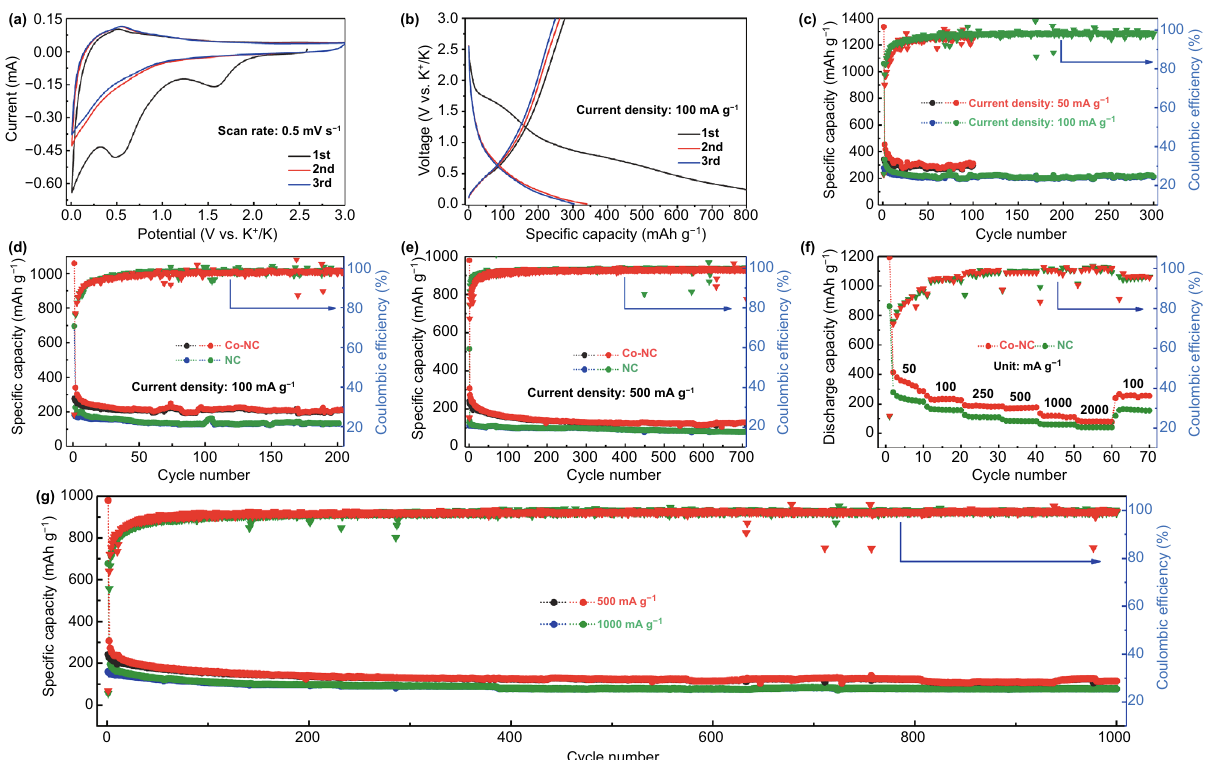
Fig. 2 a CV curve of Co-NC anode at 0.5 mV s −1 , b GCD curve of Co-NC anode at 100 mA g −1 , c cycling performance and corresponding CE of Co-NC anode at 50 and 100 mA g −1 , d cycling performance and corresponding CE of Co-NC and NC anodes at 100 mA g −1 , e cycling performance and corresponding CE of Co-NC and NC anodes at 500 mA g −1 , f rate performance and corresponding CE of Co-NC and NC anodes at 50, 100, 250, 500, 1000, 2000, and 100 mA g −1 , g long-term cycling performance and corresponding CE of Co-NC anode at 500